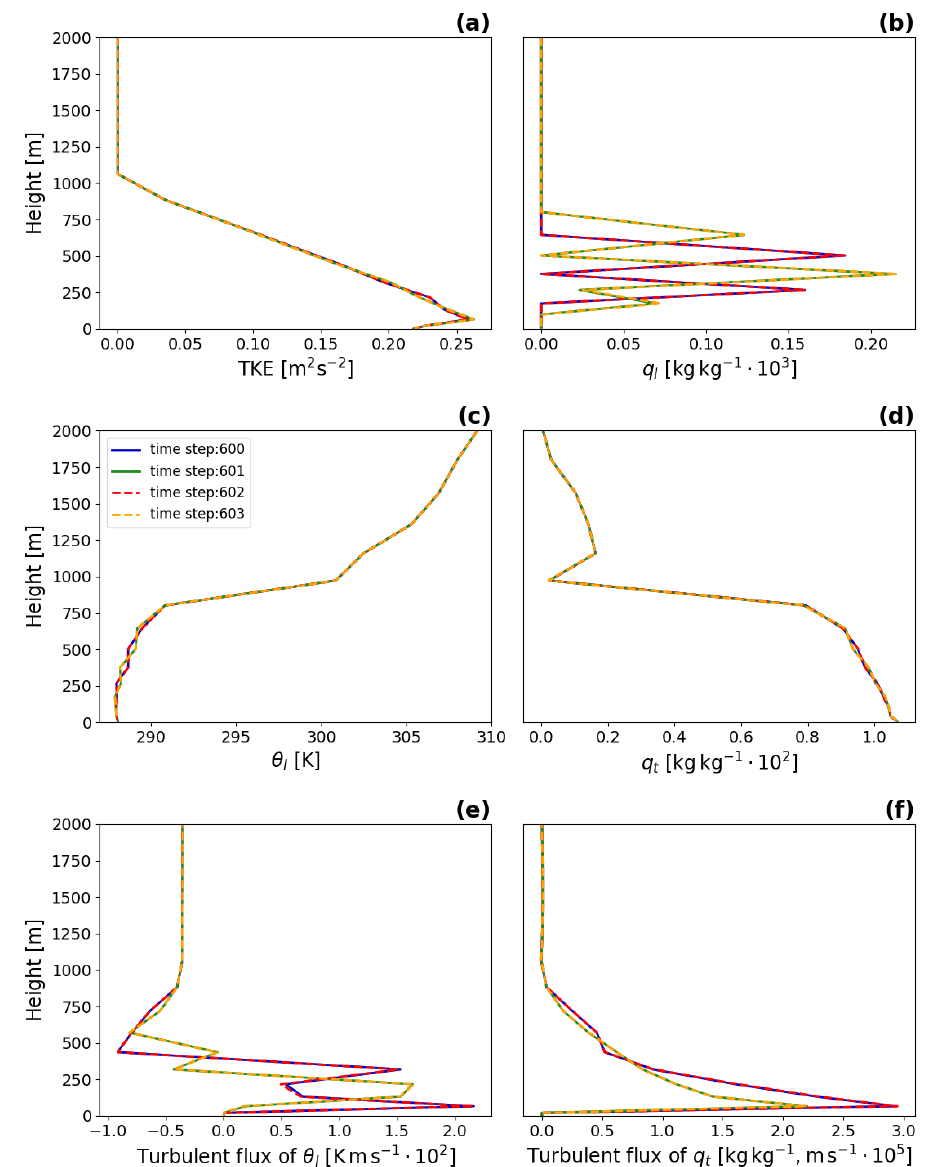
Figure 10. Results of the ICON SCM simulation with fixed TKE and deactivated convection scheme for the DYCOMS-II case. Comparison of vertical profiles of TKE ( a ), liquid water content ( b ), liquid water potential temperature ( c ), total specific water content ( d ), vertical turbulent flux of θ l ( e ), and vertical turbulent flux of q t ( f ) for four subsequent time steps after 10 h of integration (600, 601, 602, and